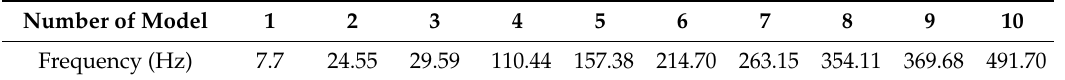
Table 5. Frequencies of the ten modes of the jointed